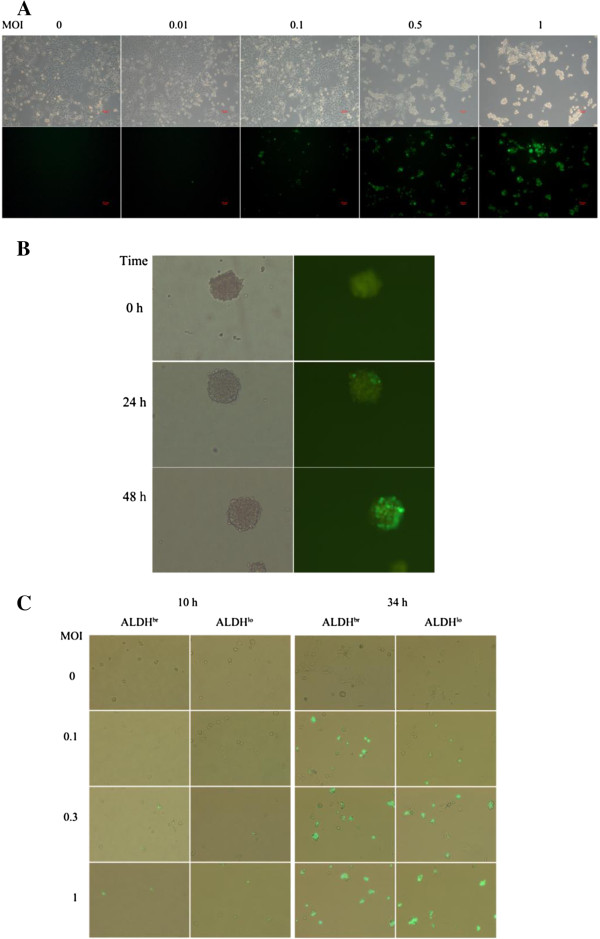
HSV1-GFP was highly oncolytic to 4T1 monolayers, mammospheres and isolated ALDHbr and ALDHlo cells. (A) 4T1 cells were infected with HSV1-GFP at different MOIs (0, 0.01, 0.1, 0.5 and 1) for 24 hours. The images were visualized using a phase-contrast microscope (top) and a fluorescence microscope for GFP expression (bottom). (B) After a 7 day culture, 4T1 mammospheres were infected with HSV1-GFP at an MOI of 1. At 24 (middle) and 48 (lower) hours after infection, the spheres exhibited a GFP signal compared with the mock-infected control (upper). The images were visualized using phase-contrast (left) and fluorescence microscopy (right). (C) Sorted ALDHbr and ALDHlo cells were infected by HSV1-GFP at different MOIs (0, 0.1, 0.3 and 1). The cell morphology and GFP expression were visualized using an inverted fluorescence microscope, and overlapping images were taken at 10 (left panels) and 33 hours (right panels) after infection (100 × objective magnifications).